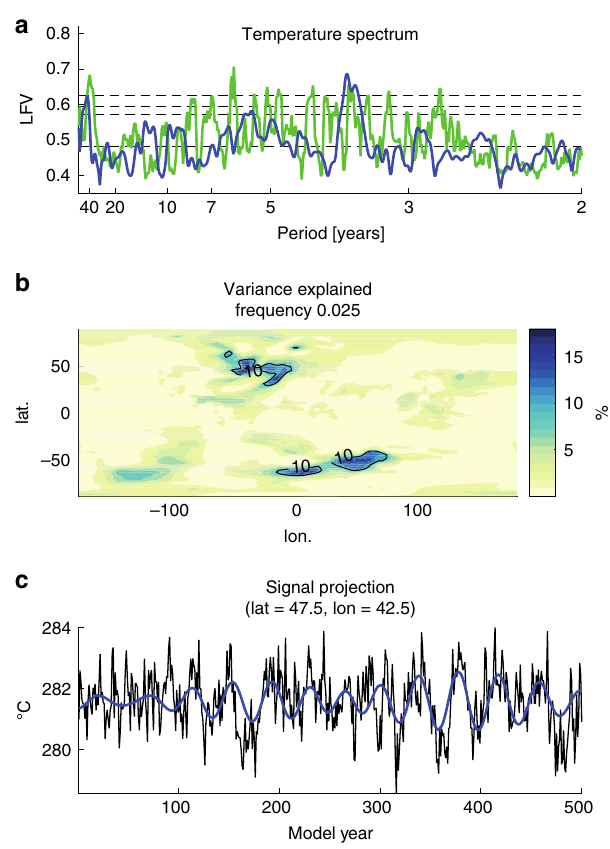
Fig. 4 Spectra of GFDL ESM-2G model control simulation. a Local Fractional Variance (LFV) spectrum (green; LFV spectrum for observational data is shown in blue for comparison, along with p = 0.5, 0.1, 0.05 and 0.01 signi fi cance levels), b spatial pattern of resolved variance associated with signal and c reconstructed time-domain signal for representative North Atlantic grid box (5° grid box centred on longitude = − 42.5 and latitude =